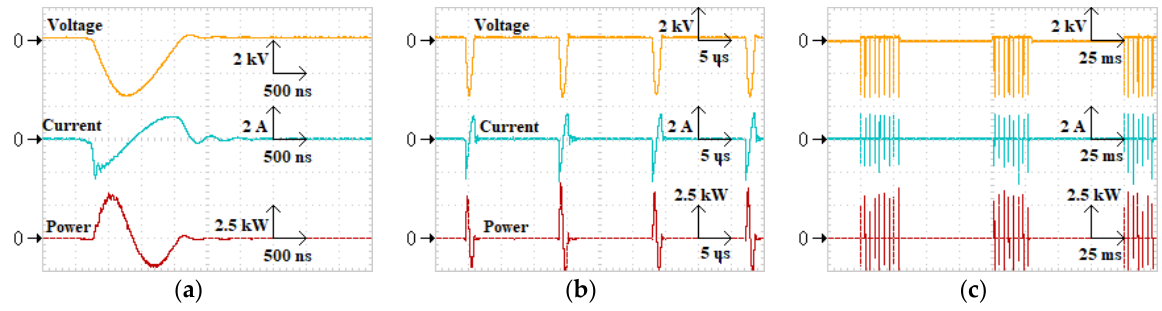
Figure 4. The waveforms of the discharge voltage, corresponding discharge current and discharge power: ( a ) 500 ns/div; ( b ) 5 μ s/div; ( c ) 25 ms/div. power: ( a ) 500 ns/div; ( b ) 5 µ s/div; ( c ) 25